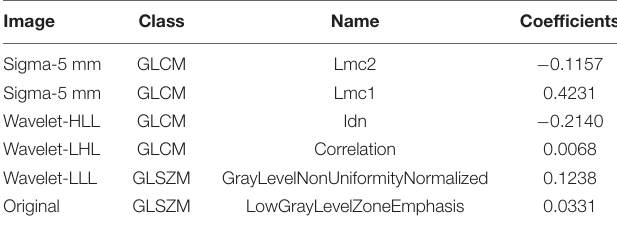
TABLE 2 | The selected radiomics features and